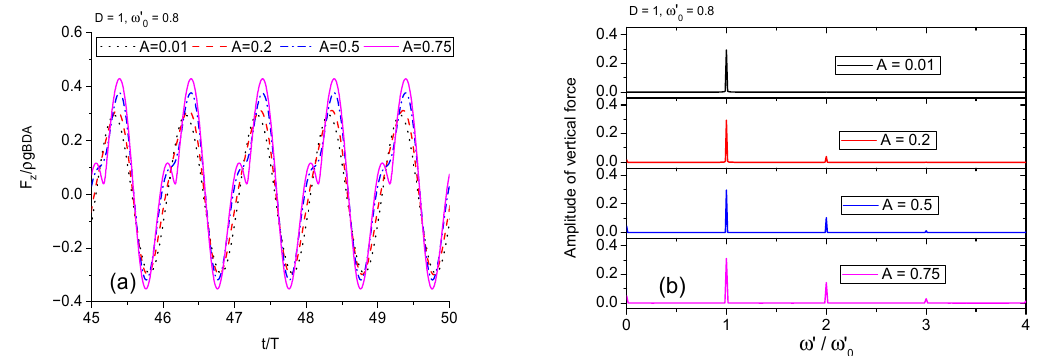
Figure 8. Vertical force histories of di ff erent motion amplitudes and their corresponding spectral analyses when ω (cid:48) 0 = 0.8: ( a ) vertical force histories; ( b ) FFT analysis of these vertical forces.